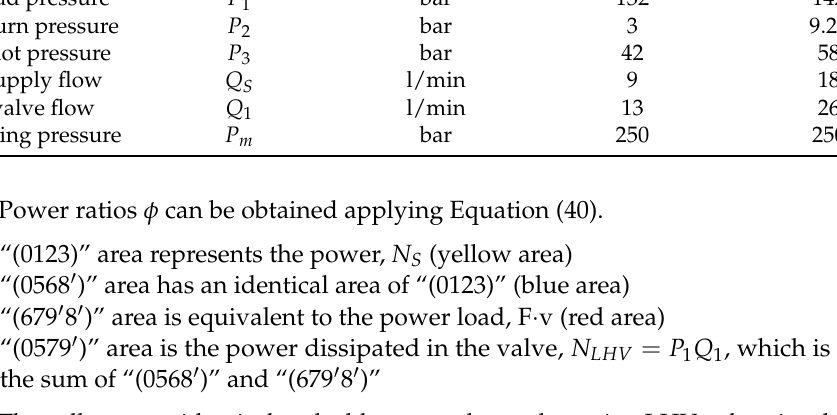
Figure 15. Graph power ratio as a function of the net force (for all cases). ( a ) M 1 machine ; ( b ) M 2 machine. Figure 16 shows the order of magnitude of the errors made in the estimation of power according to the following definition: 𝑒𝑟𝑟𝑜𝑟( % ) = 𝑁 𝑠𝑢𝑝𝑝𝑙𝑦 (𝑒𝑠𝑡𝑖𝑚𝑎𝑡𝑒𝑑) − 𝑁 𝑠𝑢𝑝𝑝𝑙𝑦 (𝑚𝑒𝑠𝑢𝑟𝑒𝑑) 𝑁 𝑠𝑢𝑝𝑝𝑙𝑦 (𝑚𝑒𝑠𝑢𝑟𝑒𝑑)